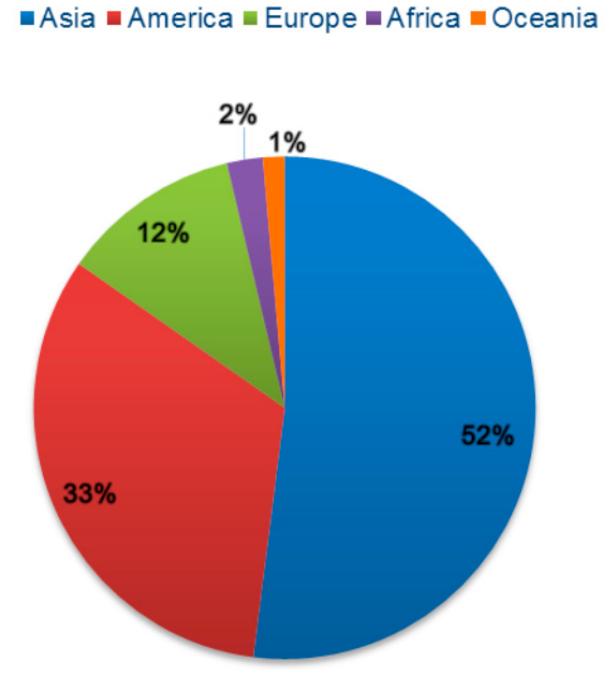
Figure 2. Use of pesticides in the world during 2012–2016 (Source: FAOSTAT. www.fao.org. Access on: 17 December 2018).